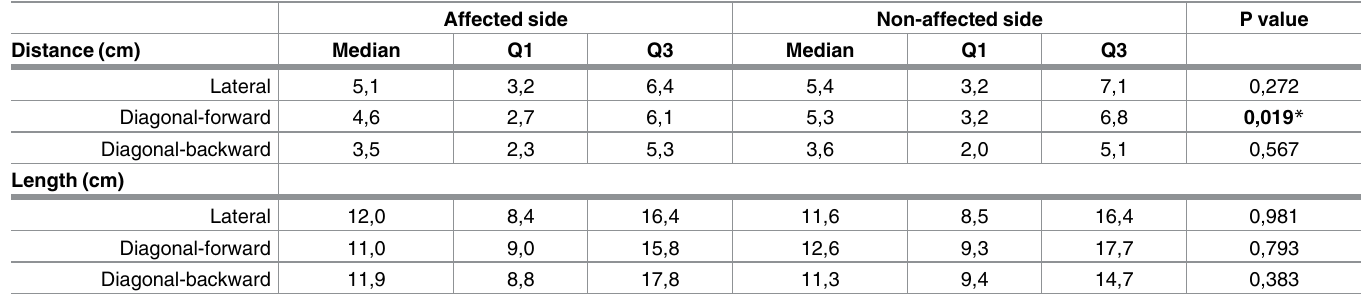
Table 3. Comparison between affected and non-affected side for force platform parameters.